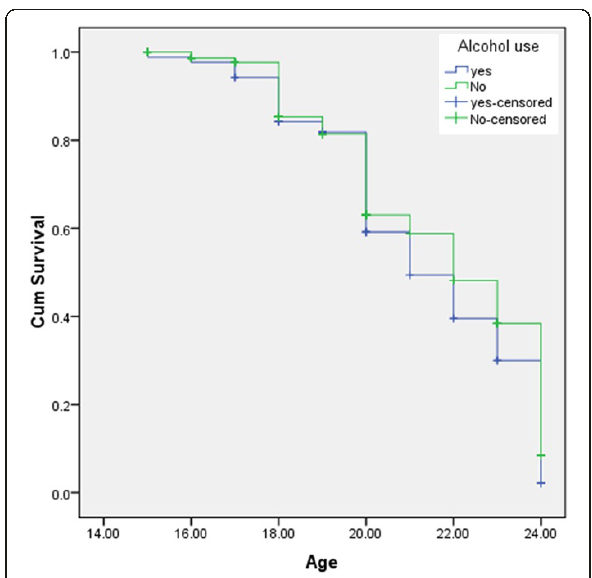
Figure 4 Kaplan-Meier indicating age at sexual initiation among youths with respect to alcohol use in Gamo-Gofa, South West Ethiopia (Log Rank chi-square = 3.75, p-value =